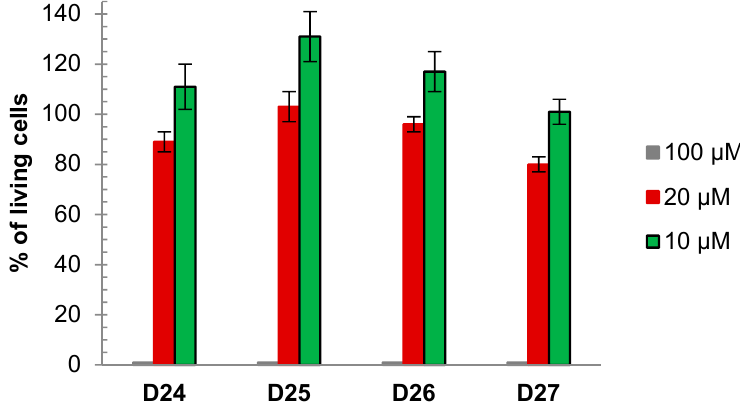
Figure 2. In vitro toxicity of dendrimers 24–27 on human melanoma cell line MeW 155 (percentage of living cells in relation to control with estimated standard deviations (E.S.Ds.)); for 100 µ M concentration of dendrimers black mark in fact denotes 100% inhibition.